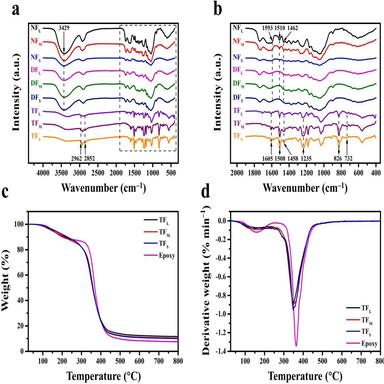
FTIR spectra of natural fibers, delignified fibers and transparent fibers, (b) is the enlarged picture in the dotted frame of (a). (c) TG and (d) DTG curves of transparent fibers and epoxy.